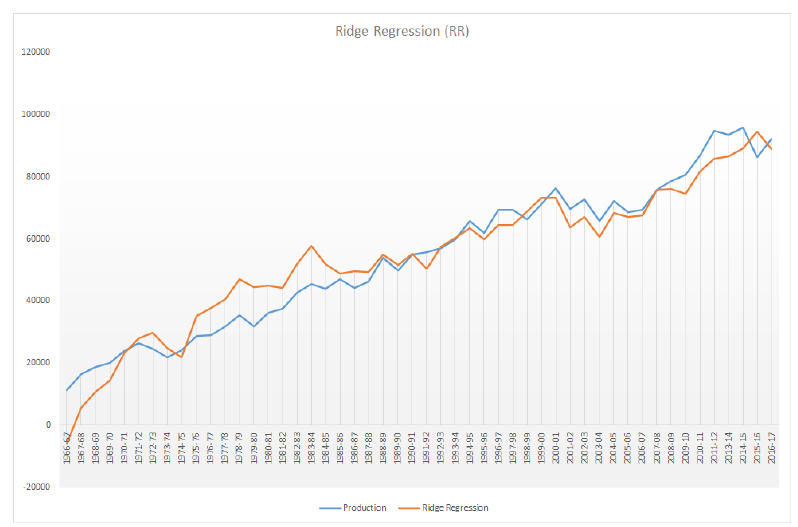
Figure 3: Forecasting using Ridge Regression